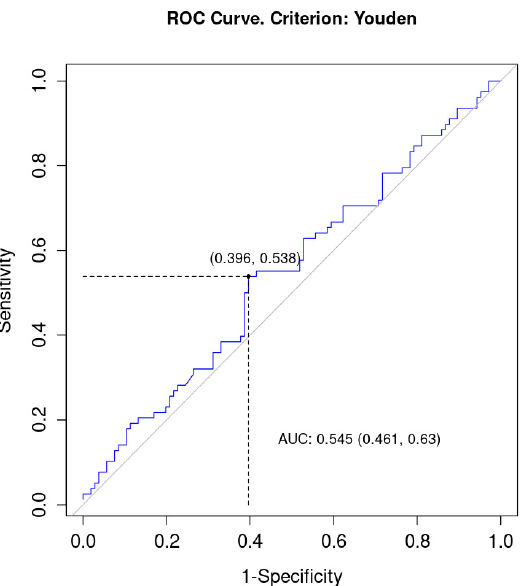
Figure 6. ROC (Receiver Operating Characteristic) curve for PLR as a discriminator of EMVI. AUC, area under curve.